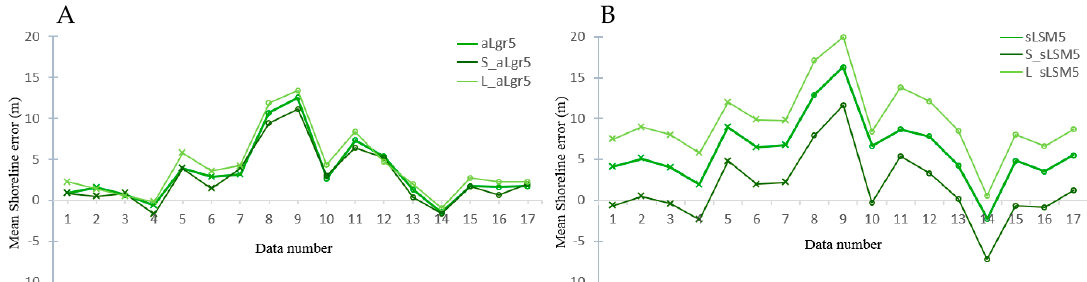
Figure 13. Mean shoreline error obtained for the 17 analysed days in the beach area by applying both aLgr and sLSM solutions respectively in A and B (accurate and inaccurate results). Small crosses and circles as markers represent L7 and L8 data accordingly. The three sub-pixel shoreline shown have been obtained with the initial pixel-level shore centred (aLgr5 and sLSM5), biased seaward (S_aLgr5 and S_sLSM5) and landward (L_aLgr5 and L_sLSM5).